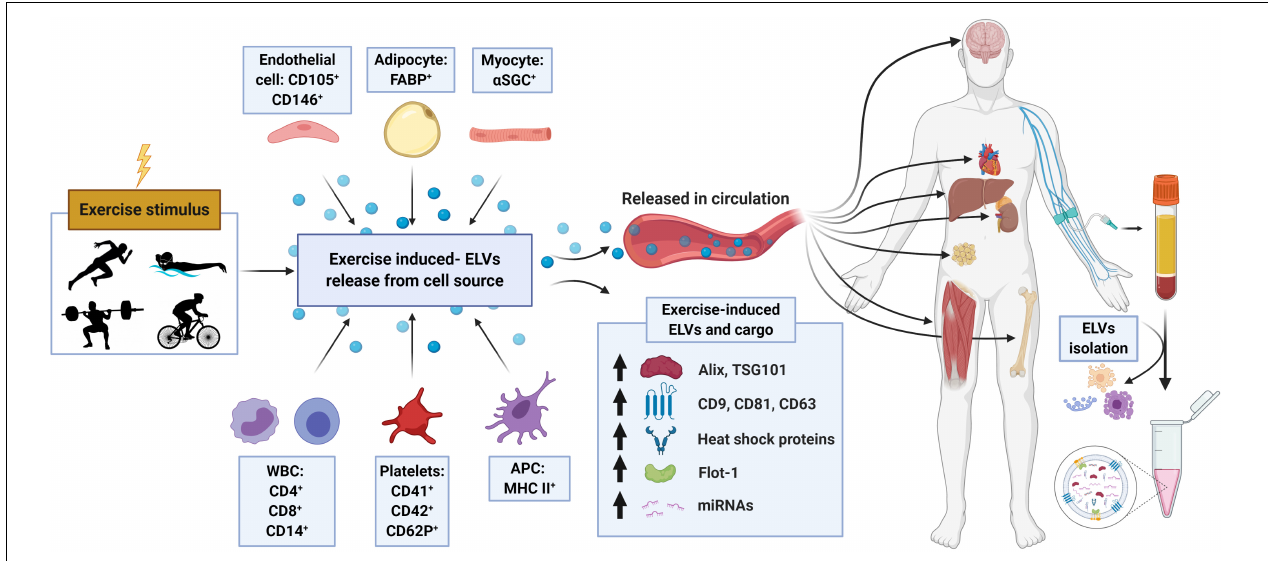
FIGURE 2 | Schematic representation of the proposed origin, release, composition, and cargo of exosome-like vesicles (ELVs) following an exercise stimulus. Following either chronic training or a single bout of exercise, ELVs may be released from muscle or other cell populations and enter into the systemic circulation. Exercise-induced alterations in plasma concentration, exosome markers (e.g., ALIX, TSG101, tetraspanins, flotillin, and heat shock proteins) and cargo (e.g., miRNA, ‘myomiR’ abundance) have been observed. APC, antigen presenting cell; α -SGC, α -sarcoglycan; FABP, fatty-acid-binding proteins; WBC, white blood cells; including monocytes and